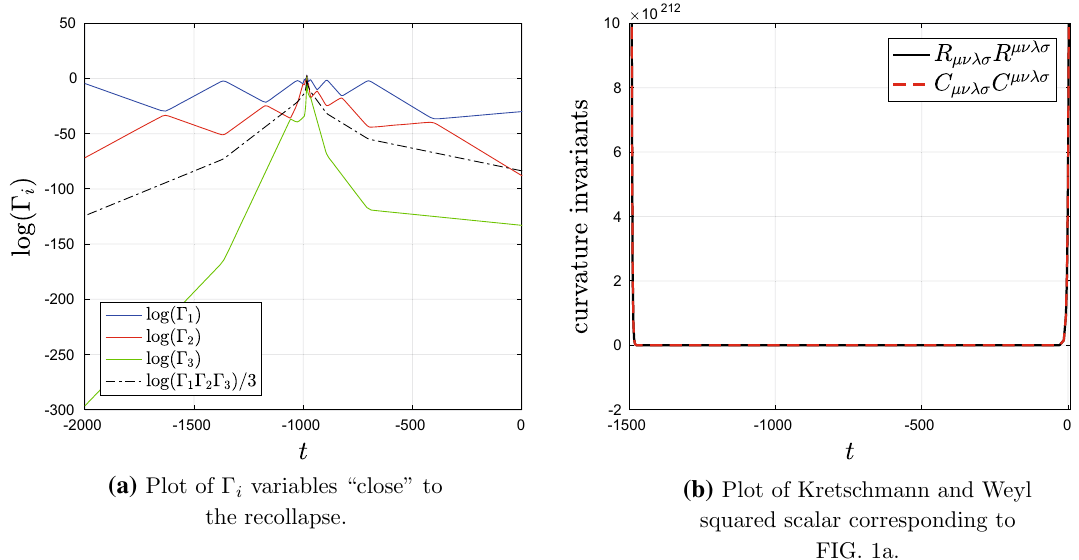
Fig. 1 Plot (a) shows the result of the application of the shooting method described in [1] “close” to the recollapse (which is roughly at t ≈ − 1000). The plot (b) was obtained from a numerical calculation based on the result of